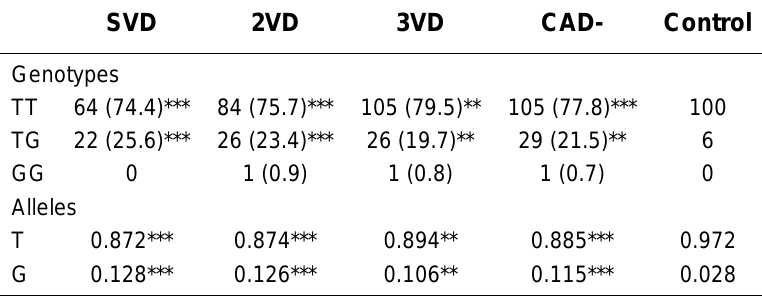
Values are expressed as number (%) for genotypes and frequency for alleles. Comparisons were made by the χ 2 test. ** p < 0.01, *** p < 0.001: compared with the control group. SVD: single-vessel disease; 2VD: two- vessel disease; 3VD: three-vessel